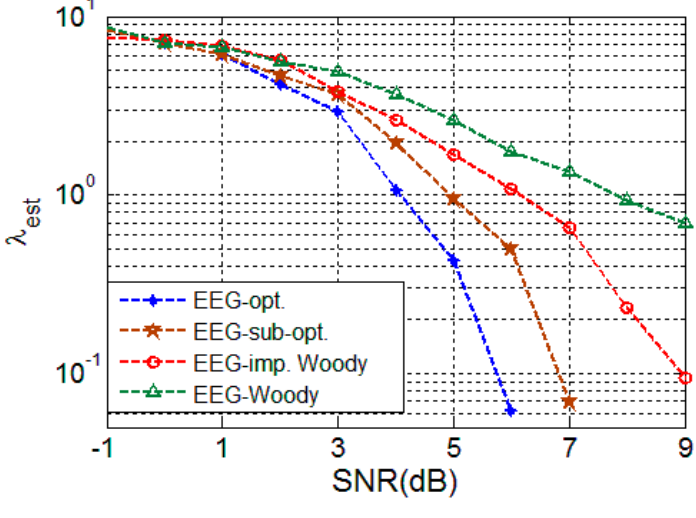
Figure 6. TDE performance for EEG signal (w4).